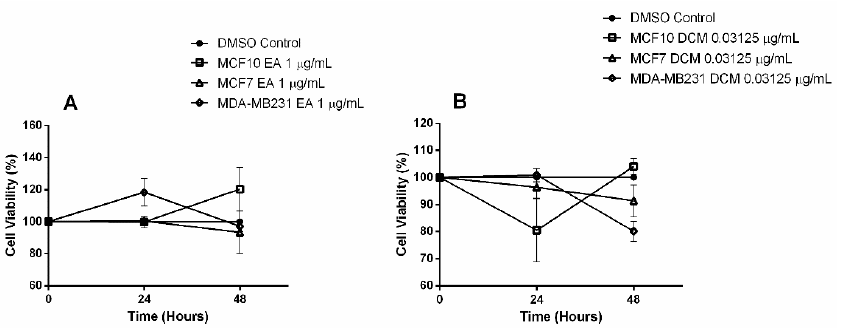
Figure 2. Time-course response to Ethanolic Extract of Neem Leaves (EENL). Treatment with 1.0 µ g/mL of EENL obtained with ethyl acetate (EENL–EA) ( A ), and EENL obtained with dichloromethane (EENL–DCM) ( B ).